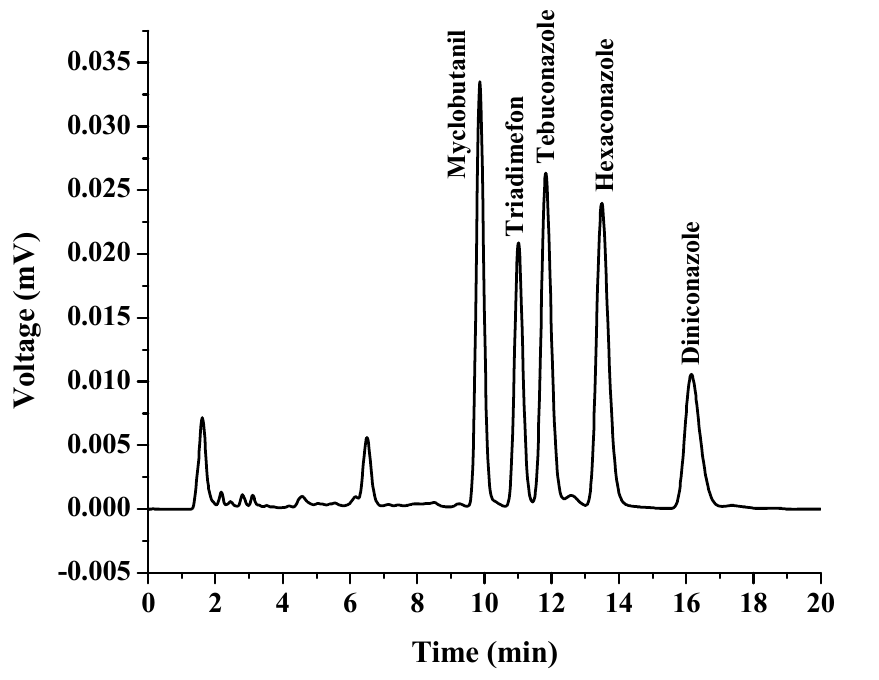
Figure 3. Extraction of triazole fungicides using mixture solvent (1-dodecanol and 1-undecanol).